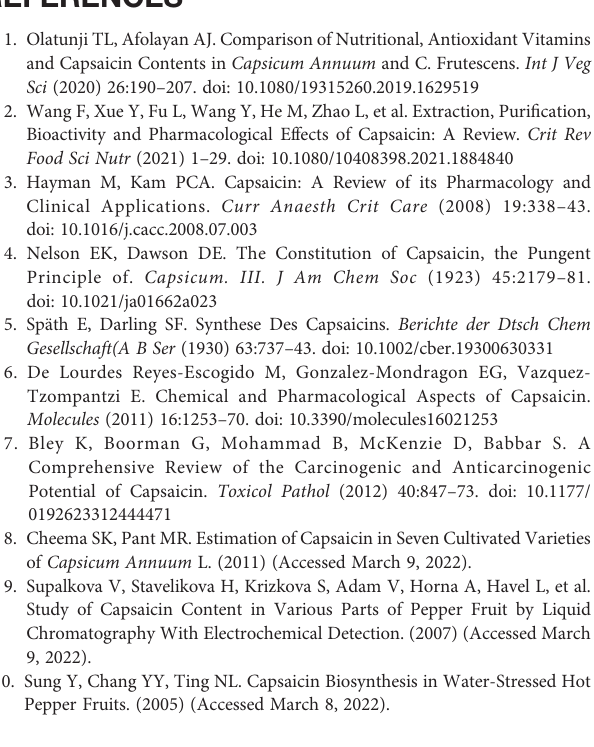
Supplementary Figure 3 | Flow chart of the bibliometric study of capsaicin showingthe selection and inclusion criteriafrom Webof Science (WoS) andScopus databases. Supplementary Figure 4 | Twenty most productive authors in capsaicin research (2001 – 2021). Supplementary Figure 5 | Network visualization map showing country collaborations on capsaicin research. The node represents countries. Node diameter signi fi es the collaboration strength of a country with other countries. Lines depict collaboration pathways between countries. Korea (North Korea and South